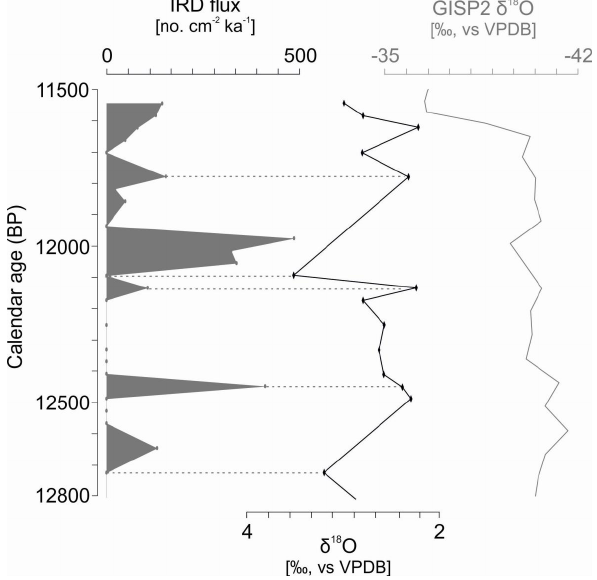
Figure 6. IRD flux (upper scale, grey shading) and oxygen stable isotopes records (bottom scale, black line) compared with oxygen stable isotope records from ice core GISP2 from Greenland dur- ing the Younger Dryas period (12800–11500calyrBP; Stuiver et al.,